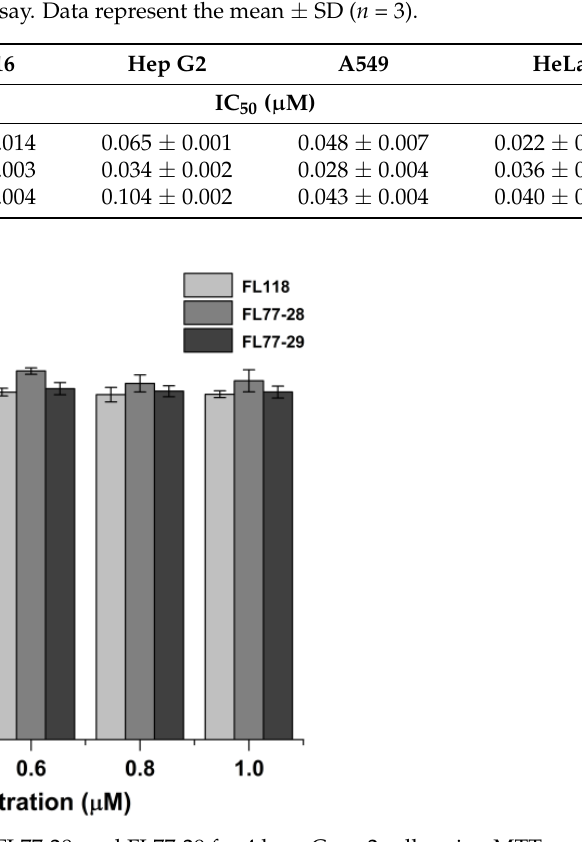
Figure 2. Cytotoxicity of FL118, FL77-28, and FL77-29 for 4 h on Caco-2 cells using MTT assay. Data represent the mean ± SD ( n = 3).